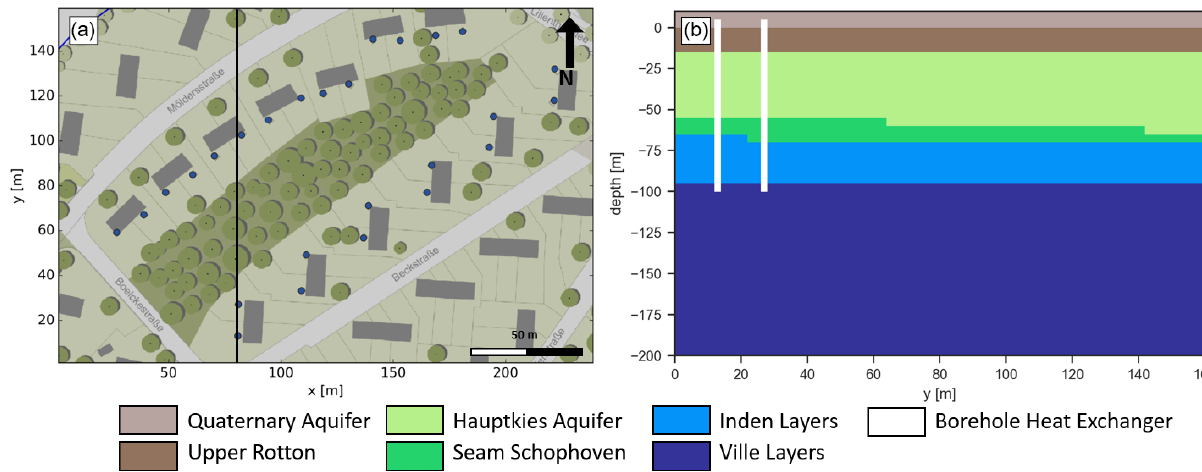
Figure 3. (a) Positions of borehole heat exchangers (blue circles) in the local numerical model (see Fig. 1 for location). Each borehole heat exchanger is assigned to one housing unit. The vertical black line marks the location for the model cross-section shown in (b) . (b) The S-N cross-section through the local model domain shows the different lithological model units (see Table 2 for their petrophysical properties). The horizontal model slices presented in the following figures are taken at a depth of 50m, i.e. at the center of the BHE and within the Hauptkies